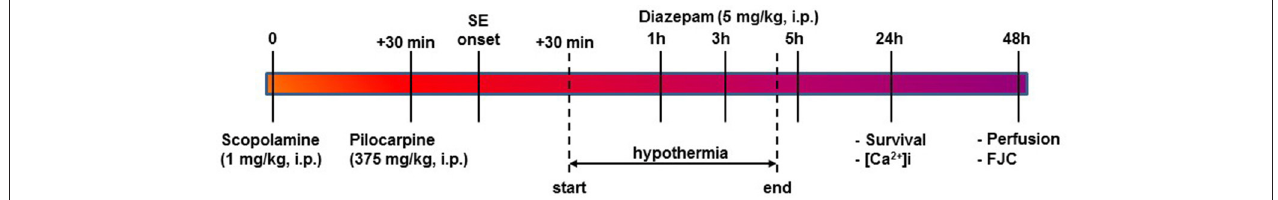
FIGURE 1 | Timeline for PILO SE, induction of HYPO, and experimental endpoints. SE was induced using PILO injection and terminated with diazepam injections as per established procedures. At 30-mins into SE, moderate HYPO was induced and then maintained for 4h using procedures described in the Materials and Methods section. At 24h post-SE, survival and ratiometric Ca 2 + imaging studies were conducted. At 48h post-SE, rats were perfused and brain sections from these rats were labeled with FJC for assessing neuronal injury as described.